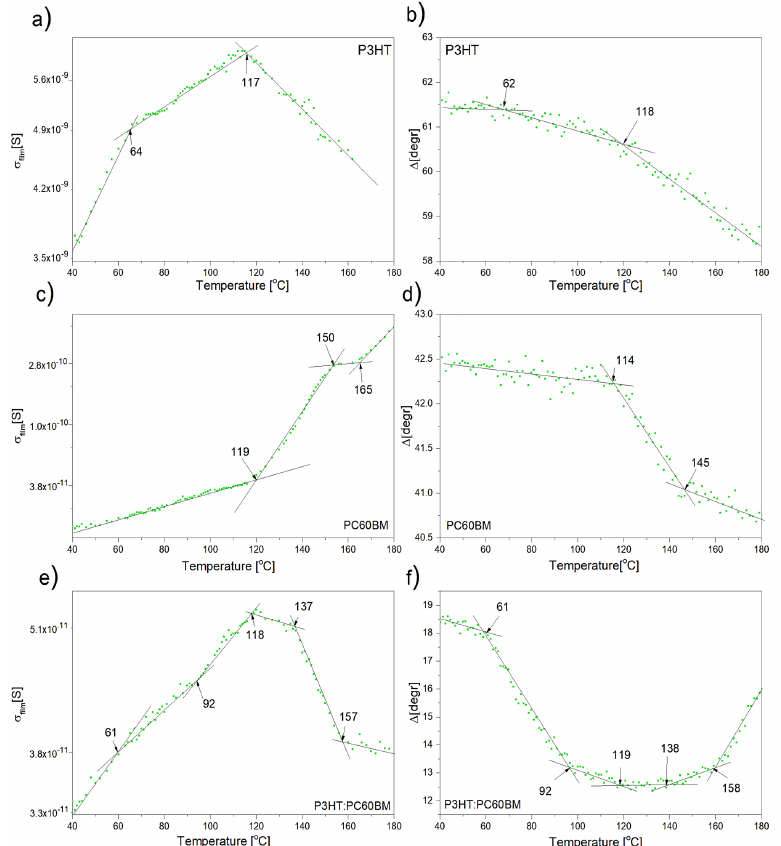
Figure 5. Left panel: The electrical conductance as a function of temperature for: ( a ) P3HT, ( c ) PC60BM, and ( e ) P3HT:PC60BM (1:1) blend. Right panel: The ellipsometric angle Δ at 280 nm as a function of temperature for: ( b ) P3HT, ( d ) PC60BM, and ( f ) P3HT:PC60BM blend.